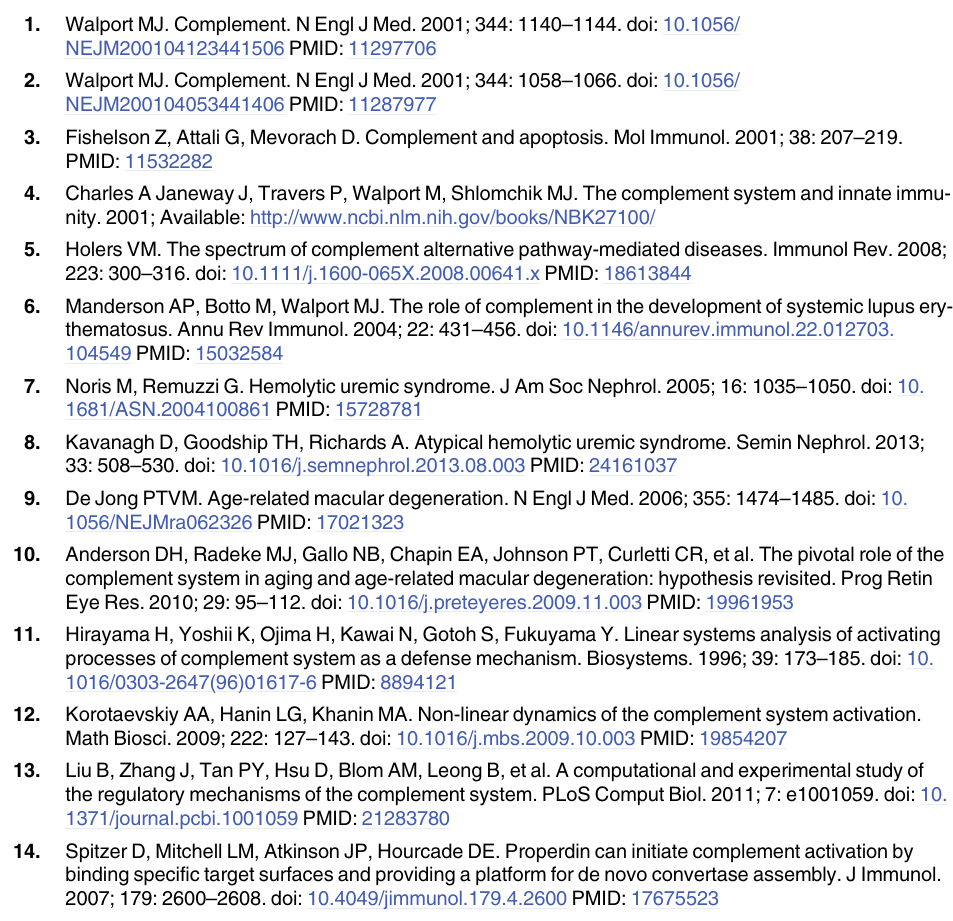
S2 Table. Complement Protein Concentrations and Molecular Masses. S3 Table. Range of Complement Protein Concentrations Implemented in Sensitivity Anal- ysis. S4 Table. Range of Kinetic Rate Constants Implemented in Sensitivity